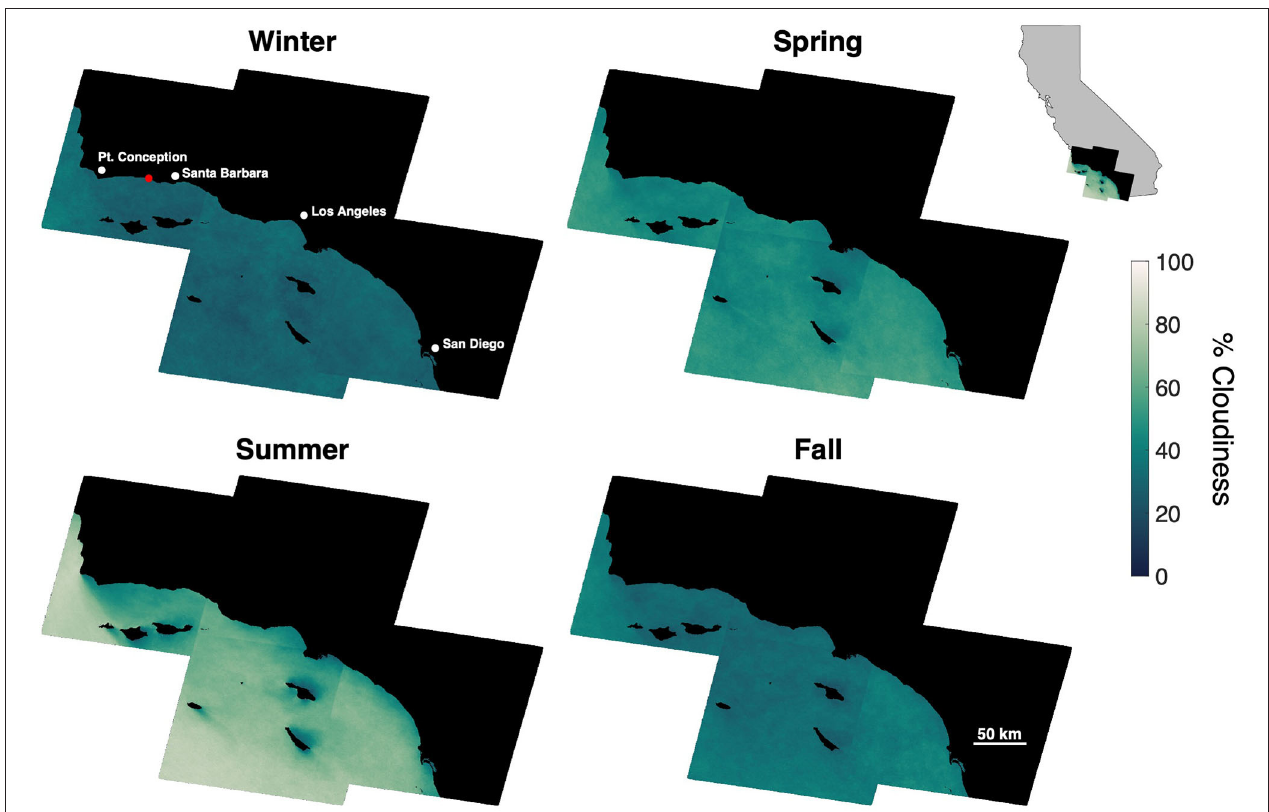
FIGURE 1 | Mean seasonal cloud cover for areas offshore of Southern California at a 30 × 30m pixel resolution, determined from 35 years of Landsat imagery (1984–2019). Red dot shows the location of the kelp forest in Figure 4 .